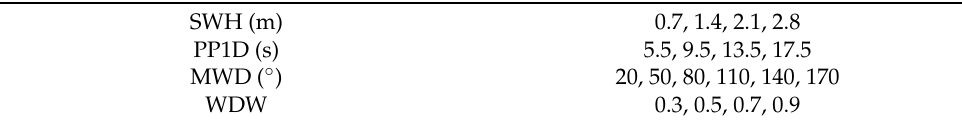
Figure 3. Comparison of the ADCP2-observed SWH and interpolated SWH from ERA5. Table 1. Port-entrance wave parameters required to generate the in-port SWH dataset using the calibrated SWASH model.